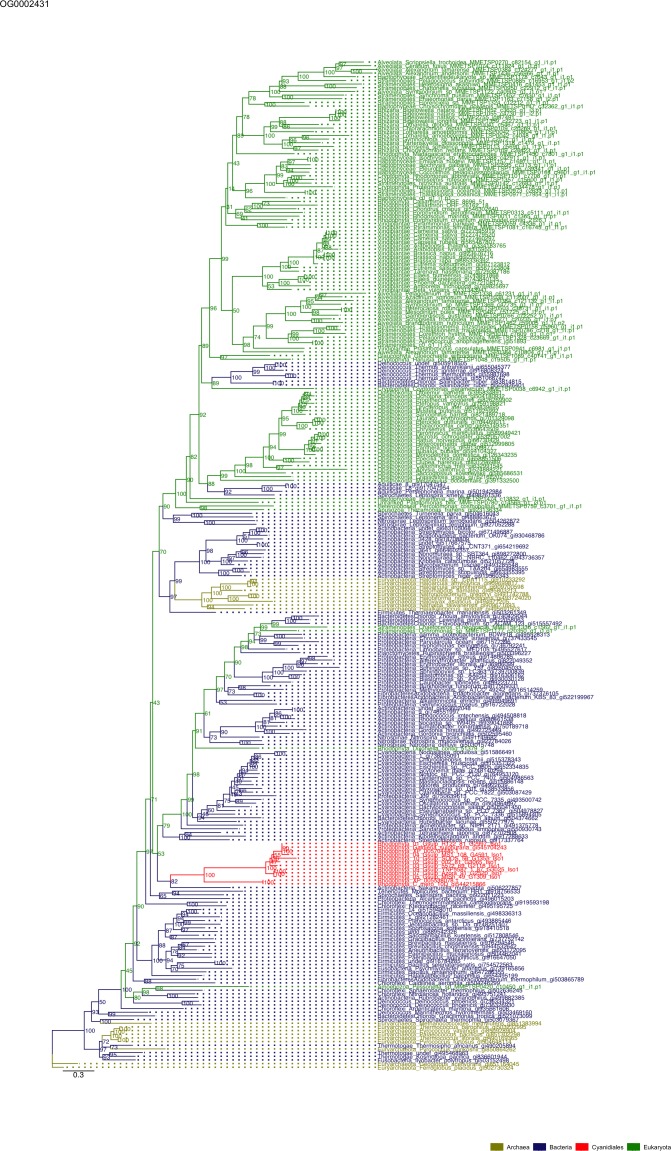
Sequence tree of orthogroup OG0002431.The tree is based on amino acid sequences. Archaea (yellow), Bacteria (blue), Cyanidiales (red), Eukaryotes including other red algae (green). Branches containing Cyanidiales sequences are highlited in red.